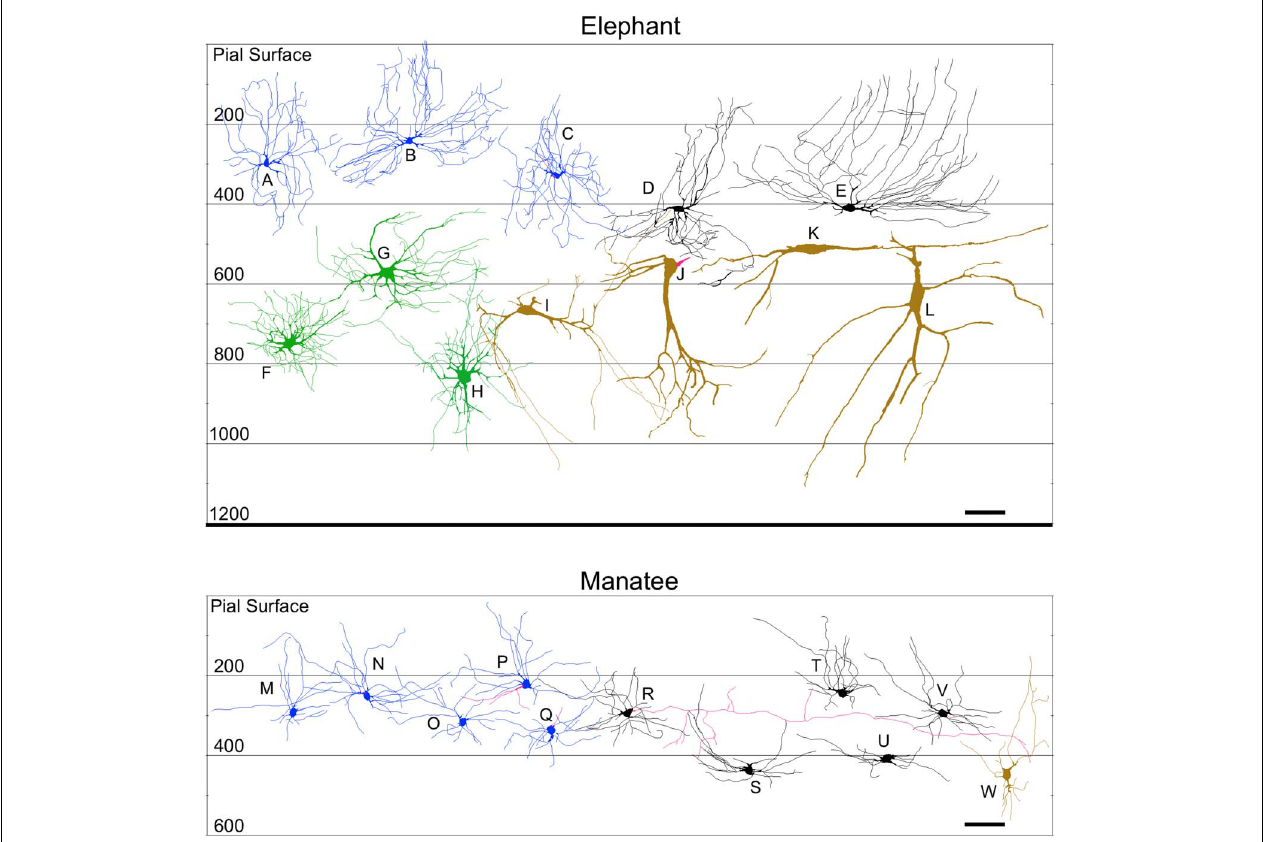
FIGURE 8 | Neurolucida tracings of neurons in the cerebellar cortex of the African elephant (top) and Florida manatee (bottom) indicating relative soma depth from the pial surface (in µ m). Stellate neurons (A–C ; M–Q) ; basket neurons (D,E ; R–V) ; Lugaro neurons (I–L; W) ; Golgi neurons (F–H) . Scale bar: 100 μ